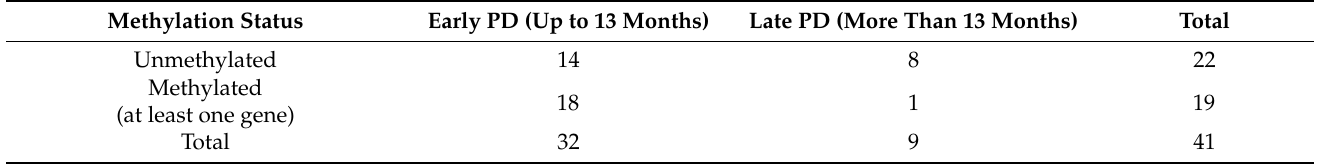
Figure 6. Direct comparison of DNA methylation markers in plasma-cfDNA and paired CTCs before osimertinib and at PD. Table 1. DNA methylation status in cfDNA and/or CTCs in respect to time-to-progression. Methylation